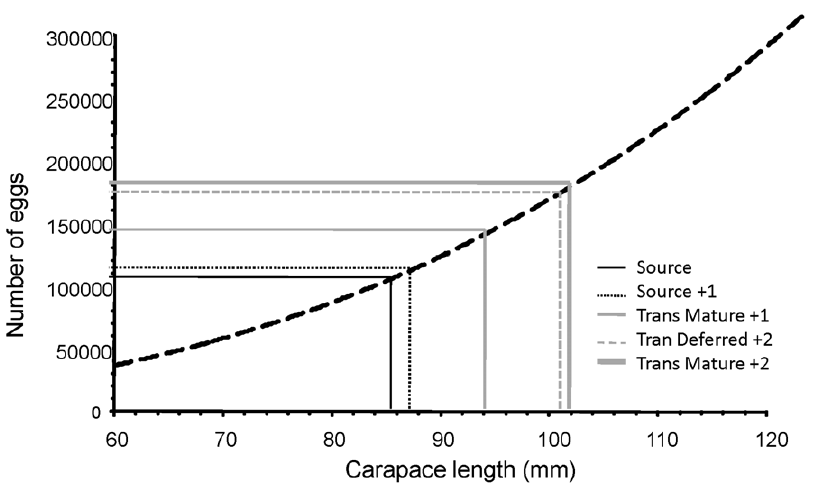
Figure 4. Estimated change in annual fecundity after translocation. Estimation change in annual fecundity after translocation for an 86 mm J. edwardsii , from on length-fecundity estimates from Green et al [33]. ‘‘Source’’ is Maatsuyker island, + 1 is after 1 year and + 2 is after two years. Mature refers to lobsters that maintained reproduction and ‘deferred’ refers to the 30% that deferred reproduction for 1 year.